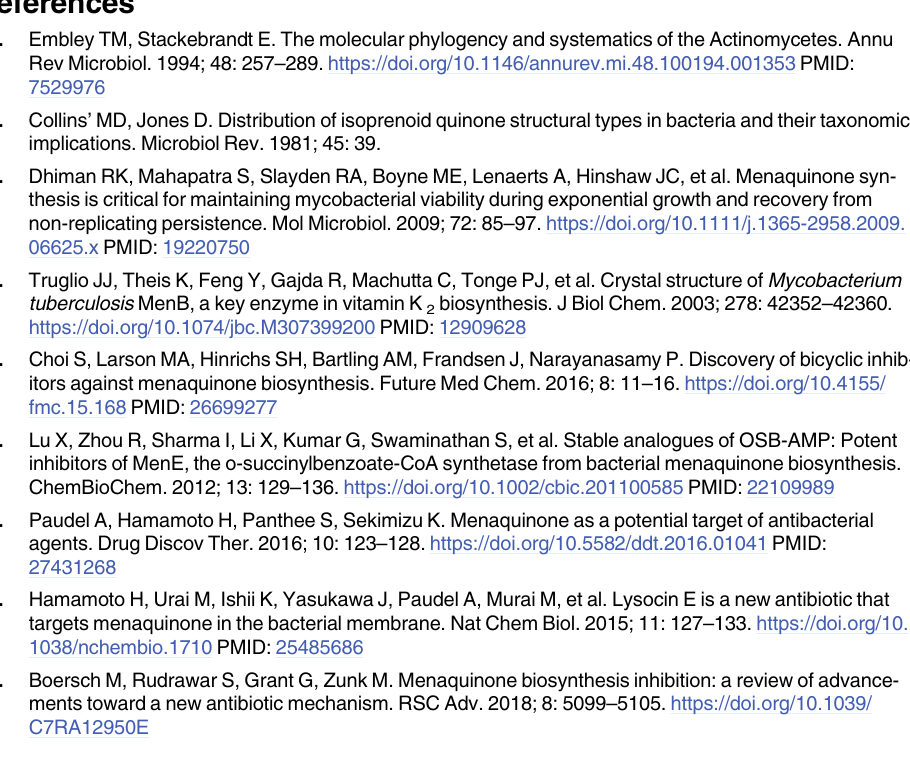
S2 Fig. Multiple sequence alignment of amino acid residues of MenA and UbiA